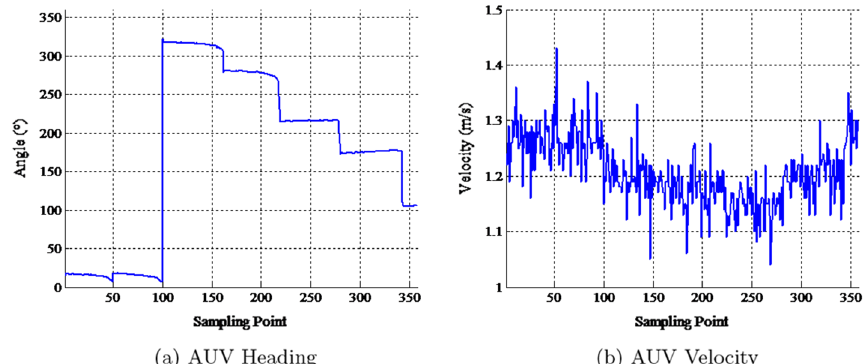
Fig. 10 AUV heading and velocity data